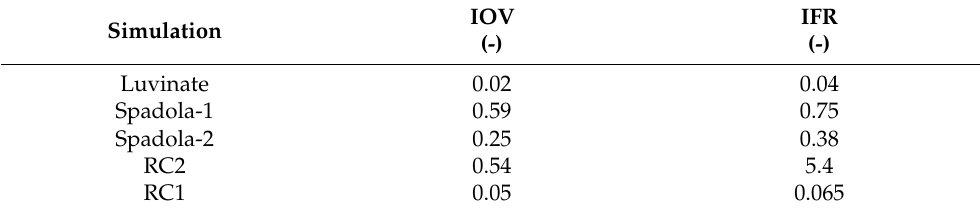
Table 3. Summary of the values related to IOV and IFR for each simulation. IOV Simulation